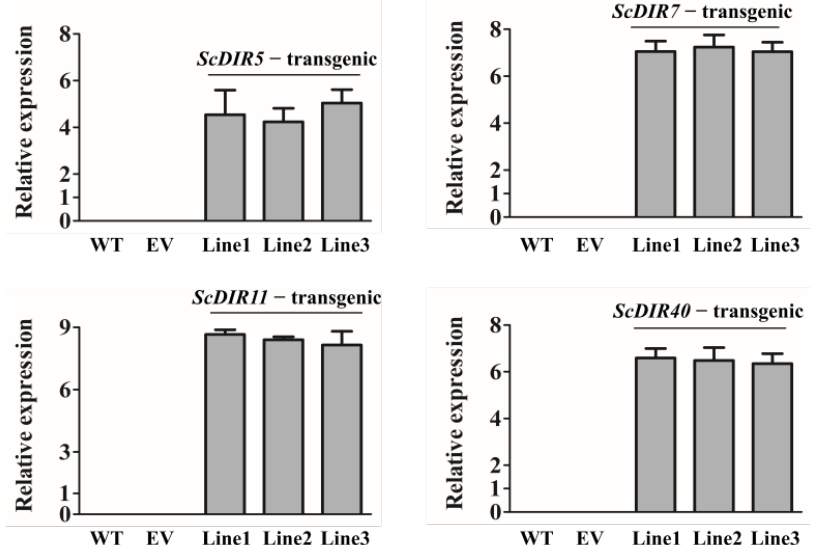
Figure 5. qRT−PCR analysis of ScDIR5 , ScDIR7 , ScDIR11 , and ScDIR40 transcript levels in three in- dependent lines, respectively. A, Expression levels of the ScDIR5 gene. B, Expression levels of the ScDIR7 gene. C, Expression levels of the ScDIR11 gene. D, Expression levels of the ScDIR40 gene. Relative expression levels of ScDIR genes were determined by qRT−PCR analysis in wild−type to- bacco (WT), tobacco with empty vector (EV), and transgenic tobacco ( ScDIR5 −transgenic, ScDIR7 −transgenic, ScDIR11 −transgenic, and ScDIR40 −transgenic lines). The GAPDH gene was used as an internal control. Error bars denote the standard deviation calculated from three independent experiments.